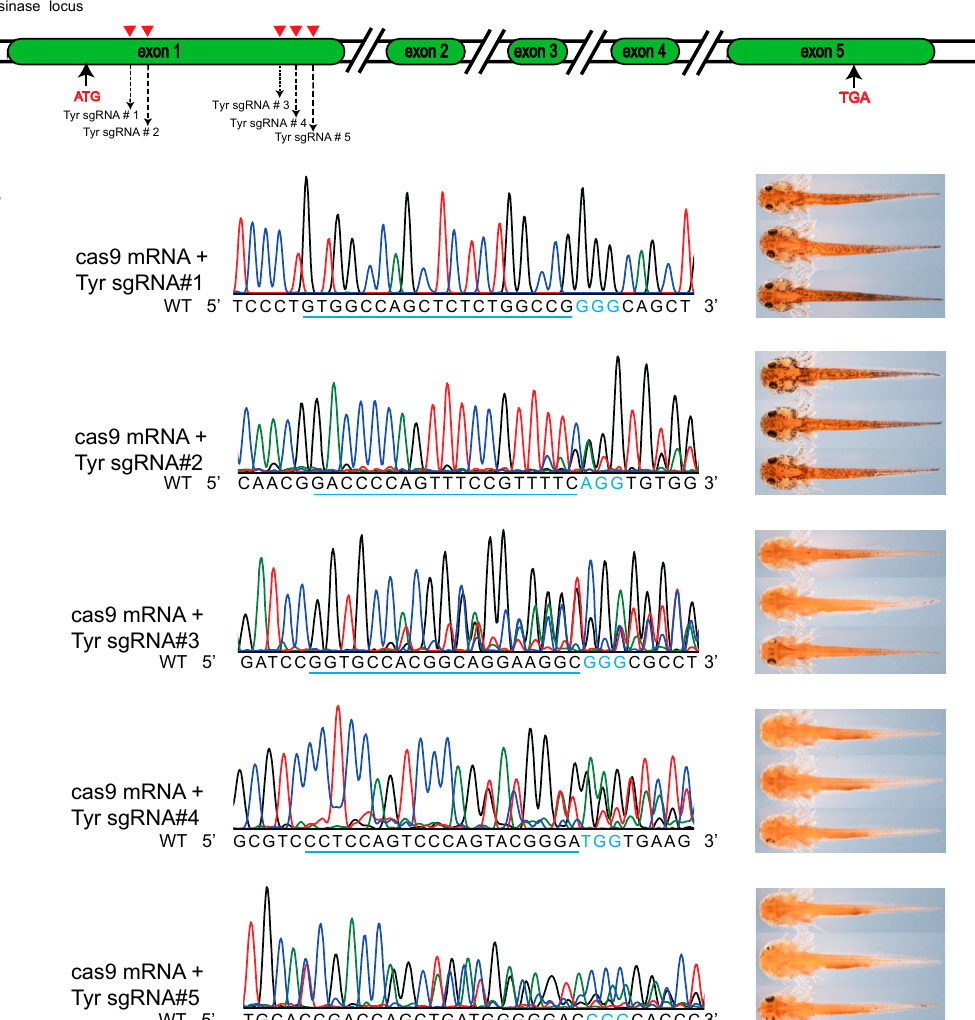
Figure 1. The scheme of the clustered regularly interspaced short palindromic repeats-associated nucleases (CRISPR) / Cas9 and base editing mediated tyrosinase ( tyr ) knockout in newt. ( A ) Five sgRNAs were designed close to the ATG start codon of the tyr exon 1; ( B ) The genotype and phenotype of the tyr knockout animals produced with the canonical CRISPR / Cas9 technique. The sanger sequencing chromatograms (left panels) and the representative pictures of corresponding animals (right panels) were shown. The predicted protospacer sites were underlined. The NGG pam site was highlighted in blue. The overlapping peaks starting around the PAM site indicated multiple mutant alleles were created. Scale bar: 2 mm. sgRNA (small guide RNA).